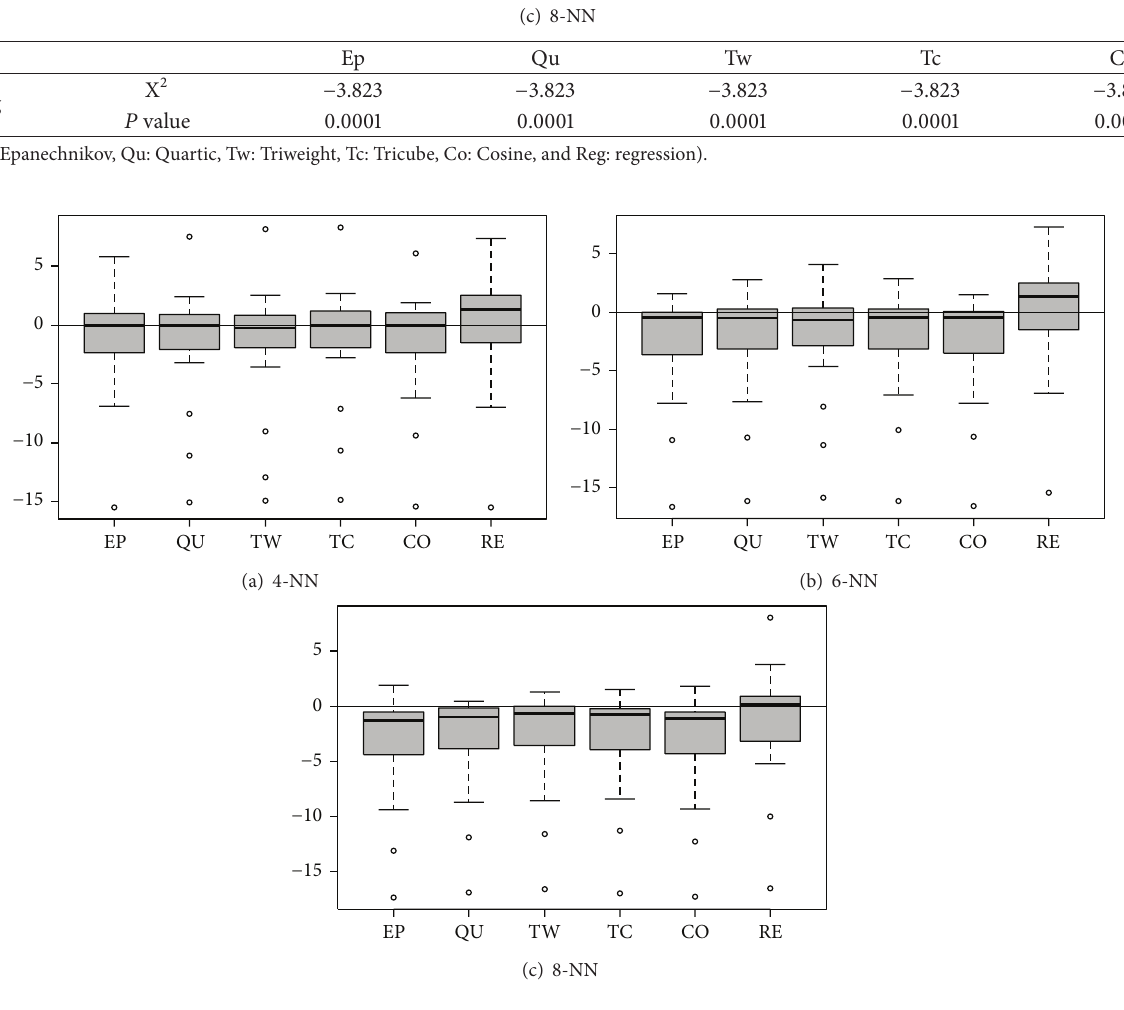
because outlying maximum values will affect the average and median